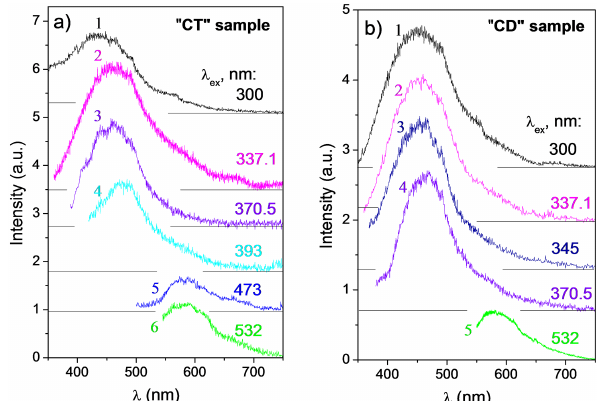
Figure 2. The PL spectra of the samples CT (a) and CD (b) ; λ ex = 300 ( a , 1; b , 1), 337.1 ( a , 2; b , 2), 345 ( b , 3), 370.5 ( a , 3; b , 4), 393 ( a , 4), 473 ( a , 5) and 532nm ( a , 6; b , 5); T = 300K.